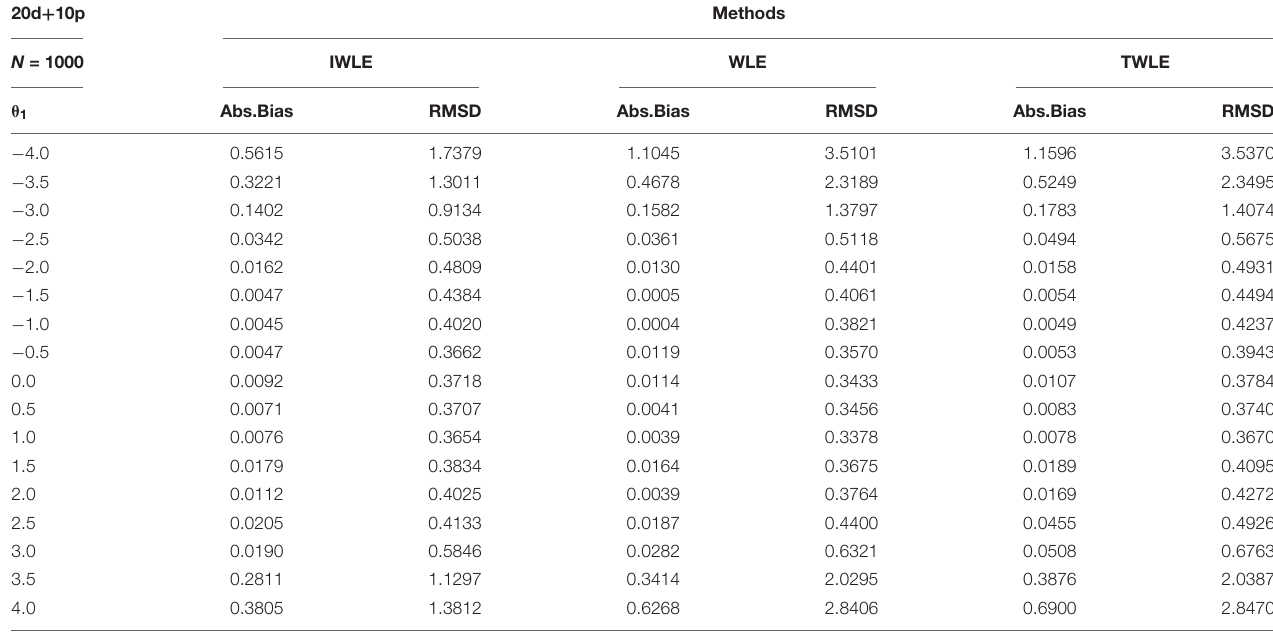
TABLE 2 | Absolute bias and root mean squared difference for WLE, TWLE, and IWLE at 17 different levels of initial ability on 20d + 10p.